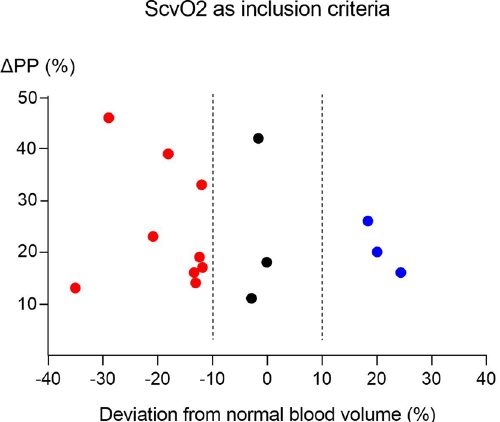
Fig. 6 Change in pulse pressure (ΔPP) following a passive leg raising test in relation to blood volume, in patients included due to ScvO2 < 70%. No significant correlation could be found ( r 0.562–0.485), p 0.85, Spearman correlation coefficient). Dotted lines illustrate limits of euvolemia [13] − =